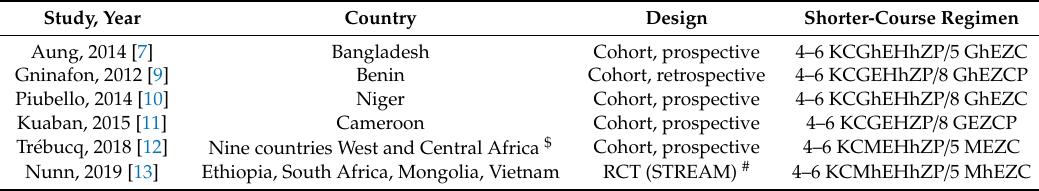
Table 1. Characteristics of published studies evaluating short-course regimens. Study,